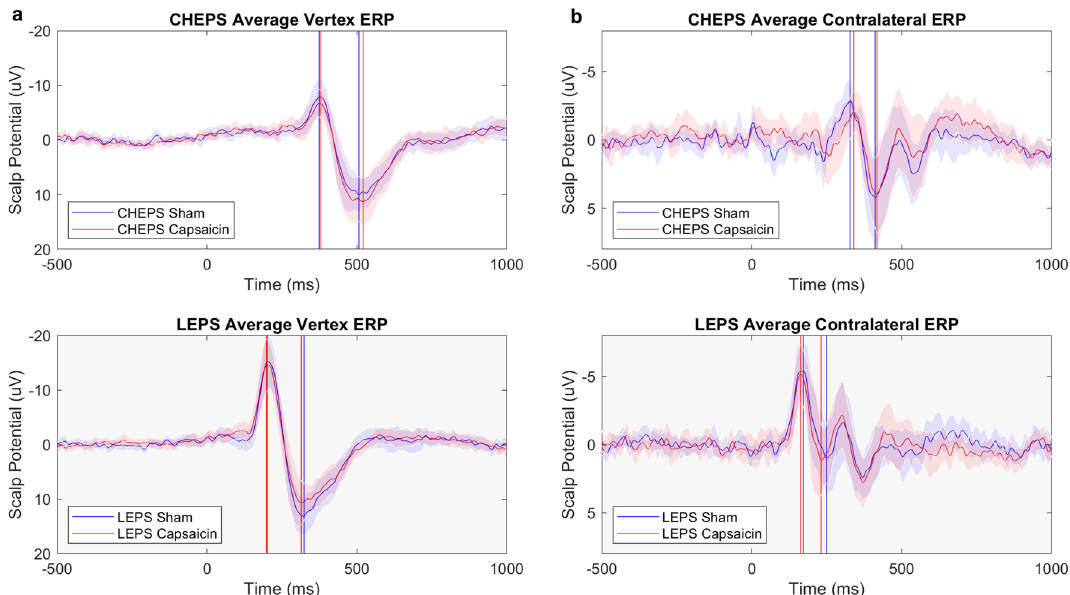
Figure 5. CHEPs and LEPs Grand Average. Illustrated are the grand average potentials measured at (column a ) the vertex (N2P2 waveform) and (column b ) contralateral electrodes C3 or C4 (N1 waveform). CHEPs are indicated with a white background and LEPs with a grey background. The blue lines illustrate the grand average of the sham condition and the red line the grand average of the capsaicin condition. Included are the 95% confidence intervals, shown with a less dense blue and red area. N2 occurs around 377 ms for CHEPs and 205 ms for LEPs. P2 occurs around 507 ms for CHEPs and 321 ms for LEPs. N = 19. N1 occurs around 327 ms and 160 ms for CHEPs and LEPs,